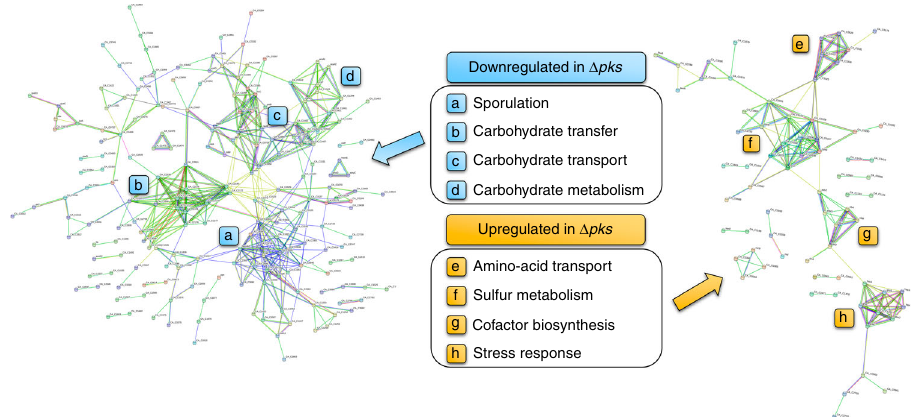
Fig. 3 RNA-Seq comparison of wild-type C. acetobutylicum and Δ pks . STRING network analysis of genes predicted to be transcriptionally downregulated (left) and upregulated (right) by RNA-Seq in Δ pks fermentation culture relative to wild type. Nodes represent differentially expressed genes, and lines represent predicted connections between genes including shared functional pathways of encoded proteins, chromosomal proximity, co-occurrence of genes in other organisms, co-expression of genes, and protein homology. For clarity, only genes with at least one predicted connection are shown. Four major concentrations of connected nodes were observed for each group (indicated by a – h ), signifying the cellular pathways most affected by deletion of the pks gene. Detailed results from the RNA-Seq analysis are presented in Supplementary Data